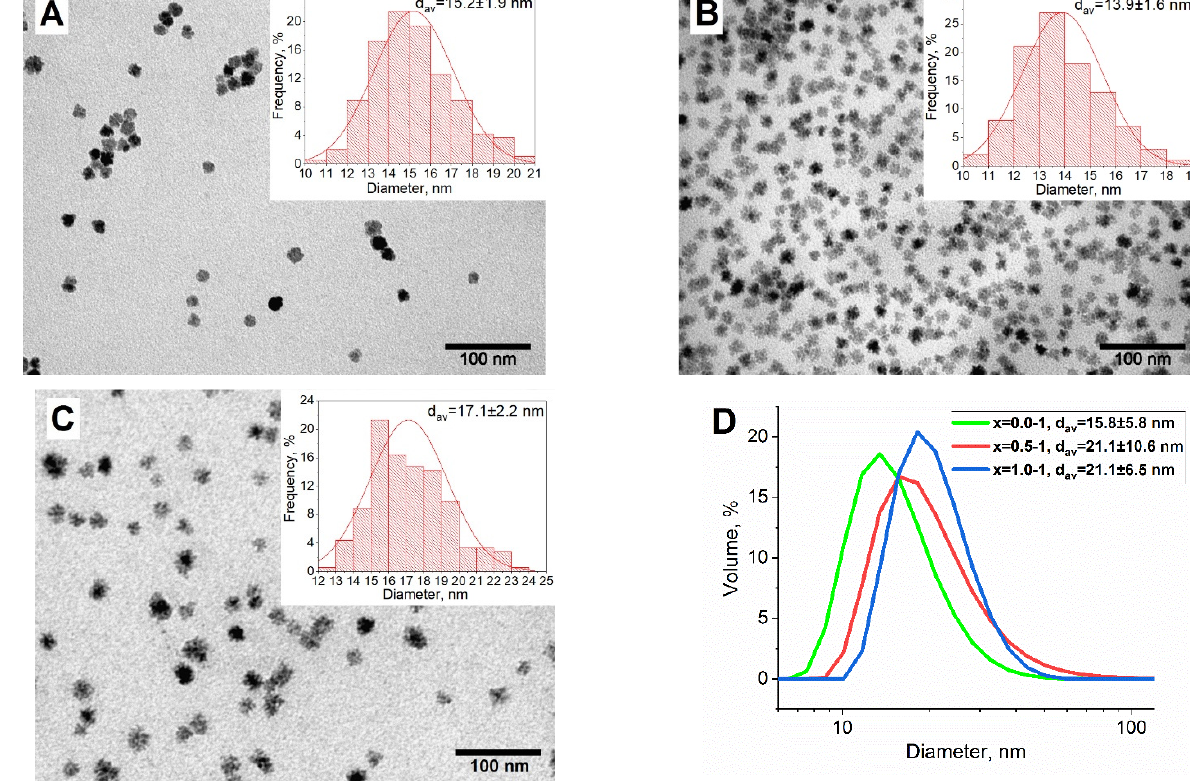
Figure 2. TEM-images and distribution by size for the MNP of x = 0.0-1 ( A ); x = 0.5-1 ( B ); x = 1.0-1 ( C ) and their hydrodynamic sizes measurements ( D ).